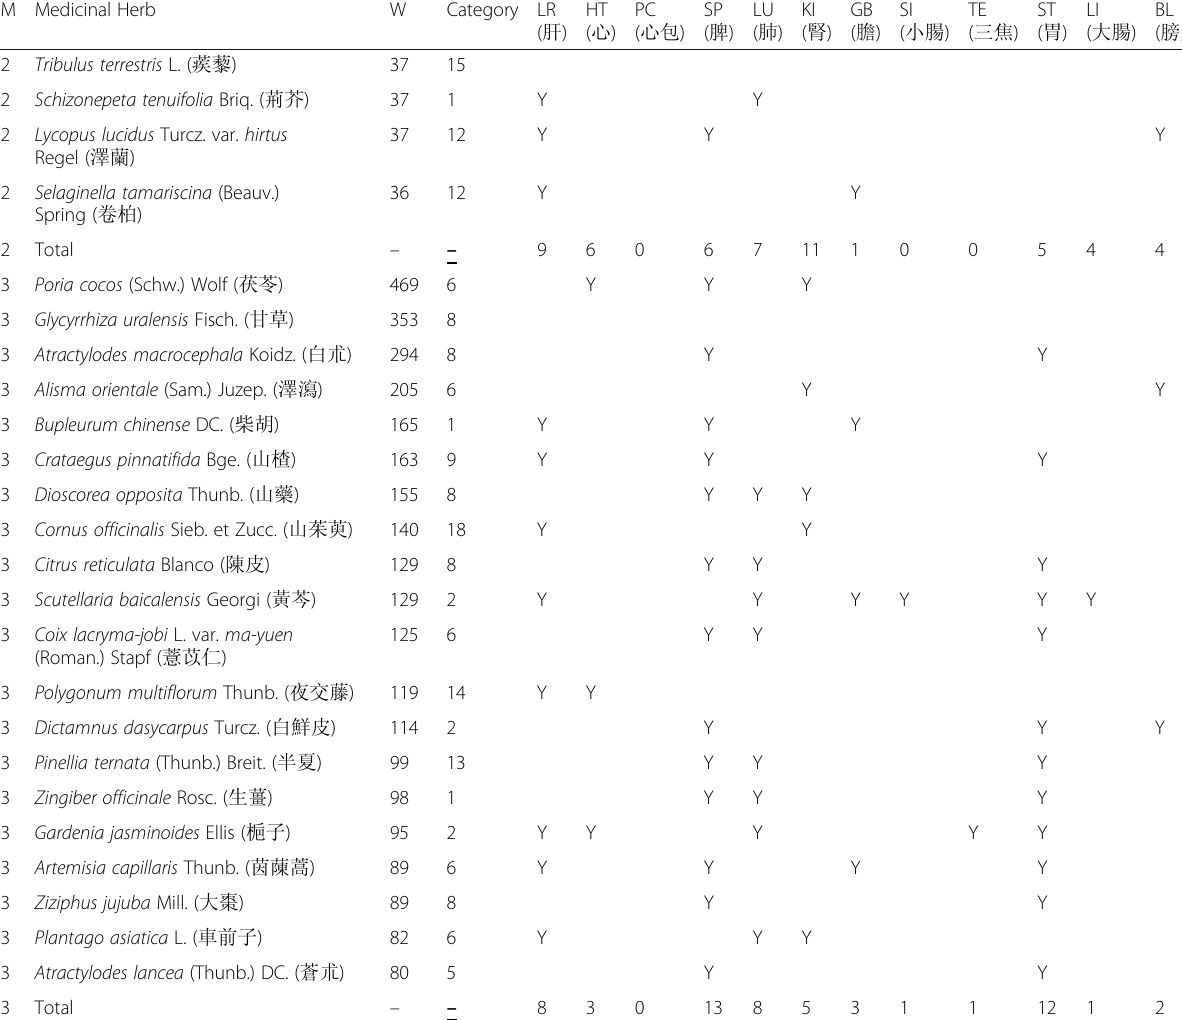
Table 4 Meridian tropism and category of the top 20 herbs in each network module (Continued) M Medicinal